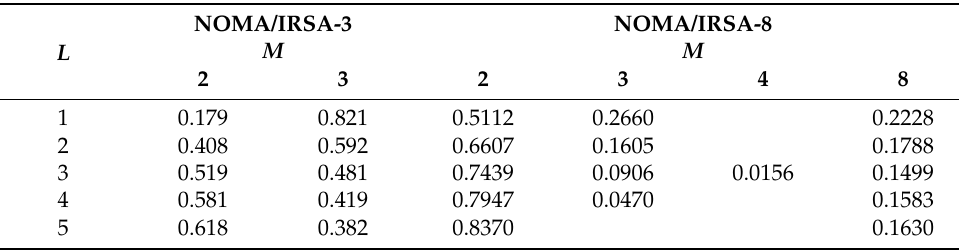
Table 1. PDF of the number M of replicas as a function of the number L of energy levels for the considered NOMA/IRSA schemes.